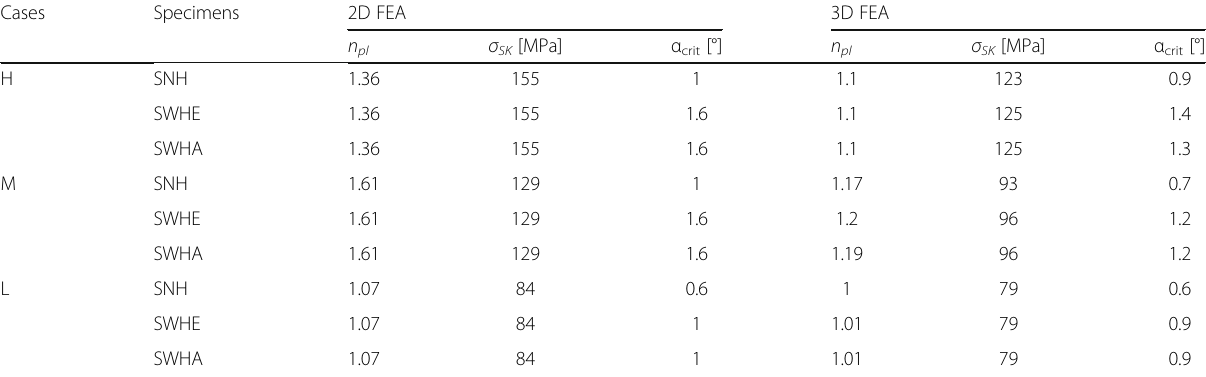
Table 11 Static strength and critical angles of the specimens with the cortical bone considered as semi-ductile